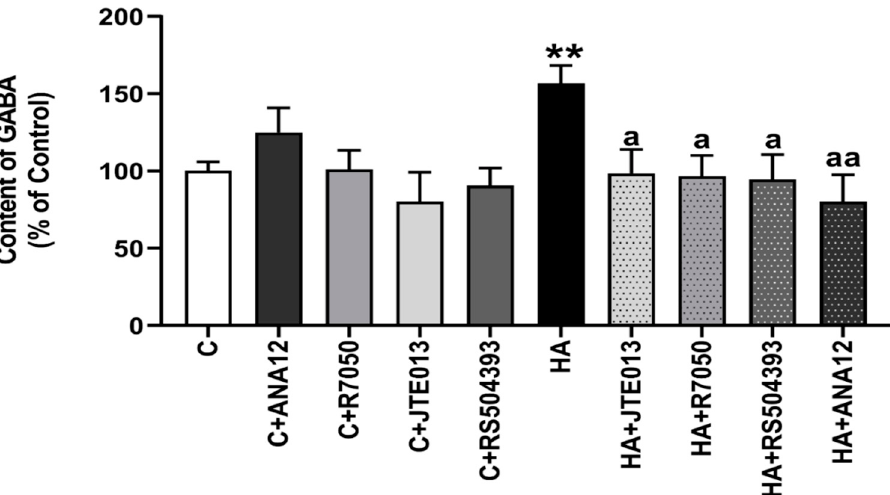
Figure 1. Hyperammonemia increases the content of GABA in cerebellar slices. Ex vivo treatment with ANA12, R7050, JTE-013, or RS504393 reverses the increase in GABA. HPLC was performed as indicated in Section 4. Values are the mean ± SEM of 12–16 rats per group. Values significantly different from control rats are indicated with asterisks, and from hyperammonemic rats are indicated with “a”. ** p < 0.01; a p < 0.05, aa p < 0.01. F = 3.628. Data were analyzed using one-way analysis of variance (ANOVA) followed by Tukey’s post hoc test.